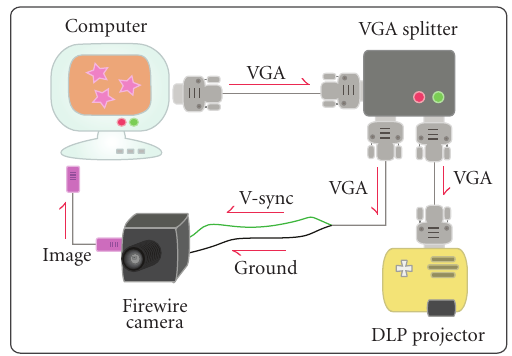
Figure 1: Setup for projector-camera synchronization.